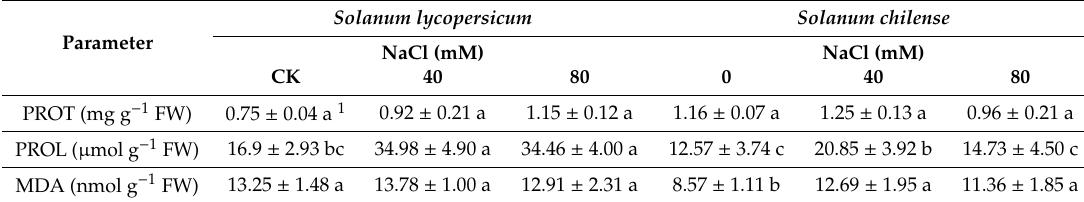
Table 1. Protein (PROT; mg / g FW), proline (PROL; µ mol / g FW) and malondialdehyde (MDA; in nmol / g FW) contents in fruits of two tomato species (cultivated Cherry tomato Solanum lycopersicum , and halophyte wild-relative S. chilense ) cultivated in the presence of 0 (CK), 40 or 80 mM NaCl. Each value represents mean ± SE ( n =